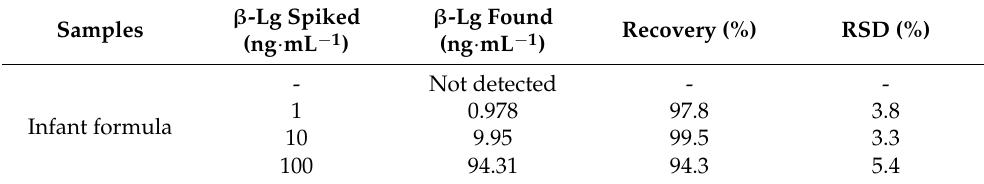
Table 3. Determination of β -Lg in infant